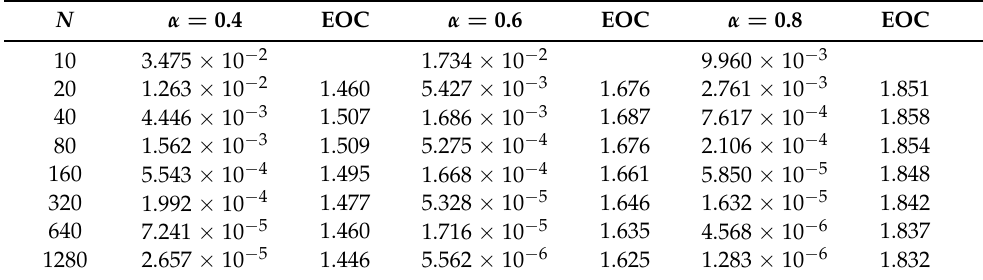
Table 1. Table showing the maximum absolute error and EOC for solving (23) using the predictor- corrector method.